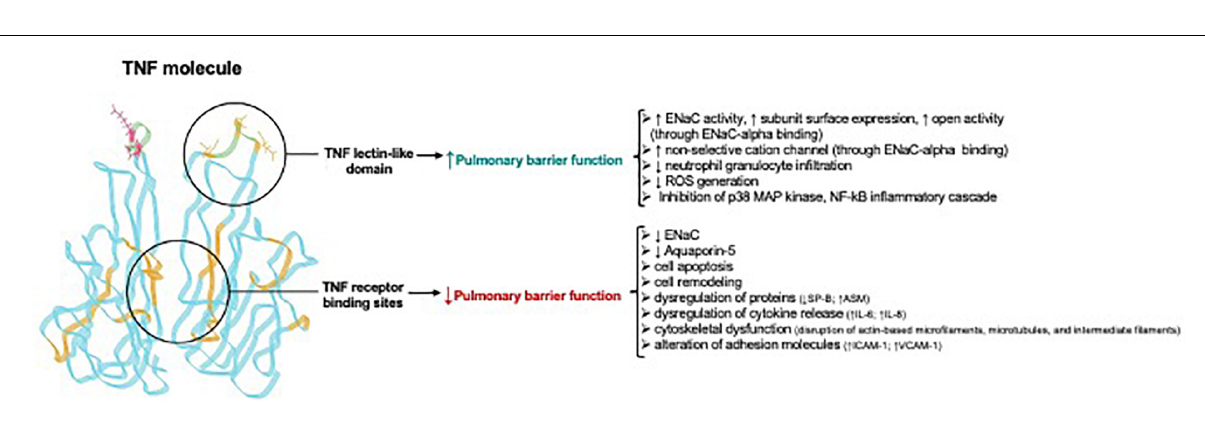
FIGURE 5 | Divergent actions of TNF receptor binding sites versus the lectin-like domain in acute lung injury Adapted from Hamacher et al. (2018). Note that the TNF receptor binding sites for TNF receptor type 1 and TNF receptor type 2 are in the regions between two TNF homotrimers and are not identical, but in part overlapping. ↑ , upregulation; ↓ , downregulation; ASM, acid sphingomyelinase; ENaC, Epithelial sodium channel; ICAM-1, intercellular adhesion molecule 1; Na + /K + -ATPase, sodium–potassium adenosine triphosphatase; VCAM-1, vascular cell adhesion molecule-1; ROS, reactive oxygen